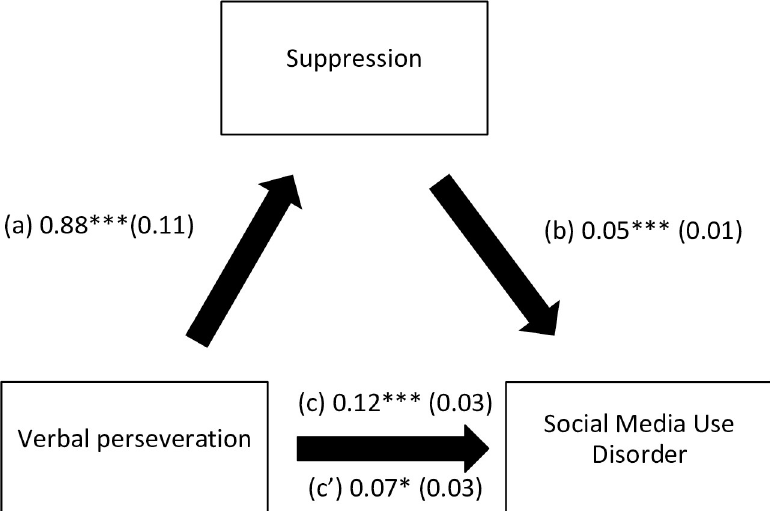
Fig 1. (a) Relation between verbal perseveration and suppression (R 2 = 20.38%); (b) Relation between suppression and social media use disorder (R 2 = 13.92%); (c) Total effect of the relation between verbal perseveration and social media use disorder (R 2 = 9.55%); (c’) Direct effect of the relation between verbal perseveration and social media use disorder. Numbers are displayed as regression coefficients (standard error). ��� p < 0.001; � p < 0.05.